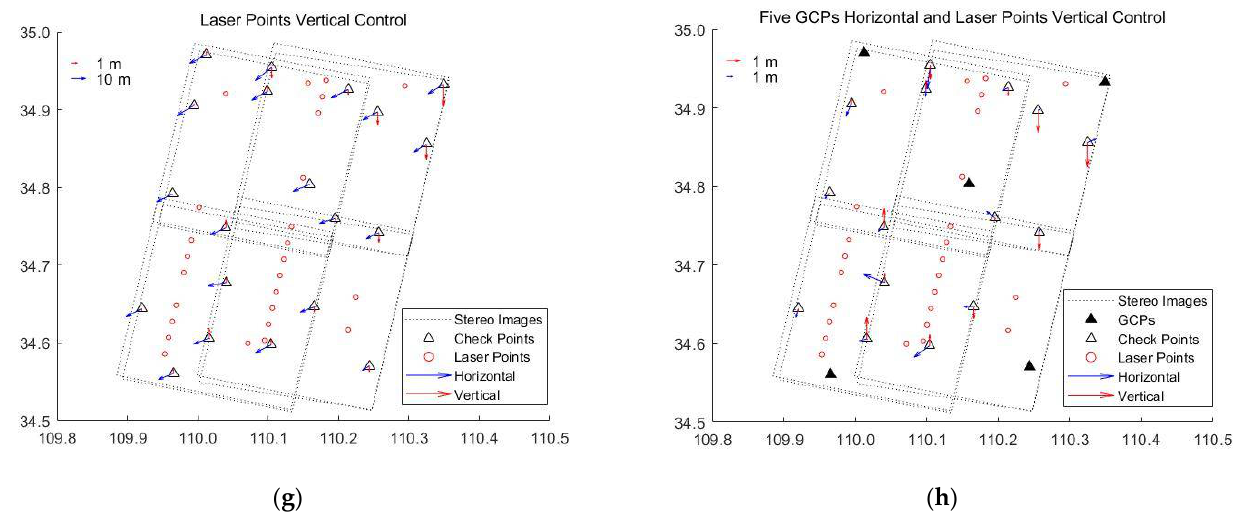
Figure 9. Accuracy assessments in the Shaanxi area. ( a ) No control, ( b ) all GCPs control, ( c ) five GCPs control, ( d ) LPs control, ( e ) five GCPs horizontal control, ( f ) five GCPs vertical control, ( g ) all LPs vertical control, ( h ) five GCPs horizontal and LPs vertical control.